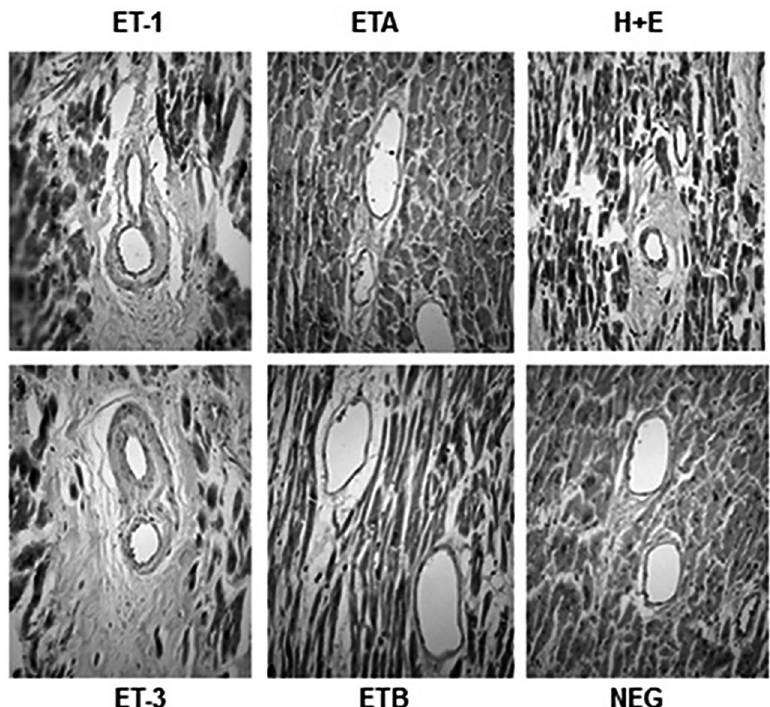
Fig. 2 - Immunostaining of sections of stenotic valve from a patient with rheumatic fever. Top left. ET-1 staining associated with fibrotic regions and neovascularization. Top middle. ETA receptor staining of fibrotic region and neovascularization. Top right. H + E-stained section. Lower left. No ET-3 immunostaining. Lower middle. ETB receptor immunostaining of fibrotic region and neovascularization. Lower right. Negative control.